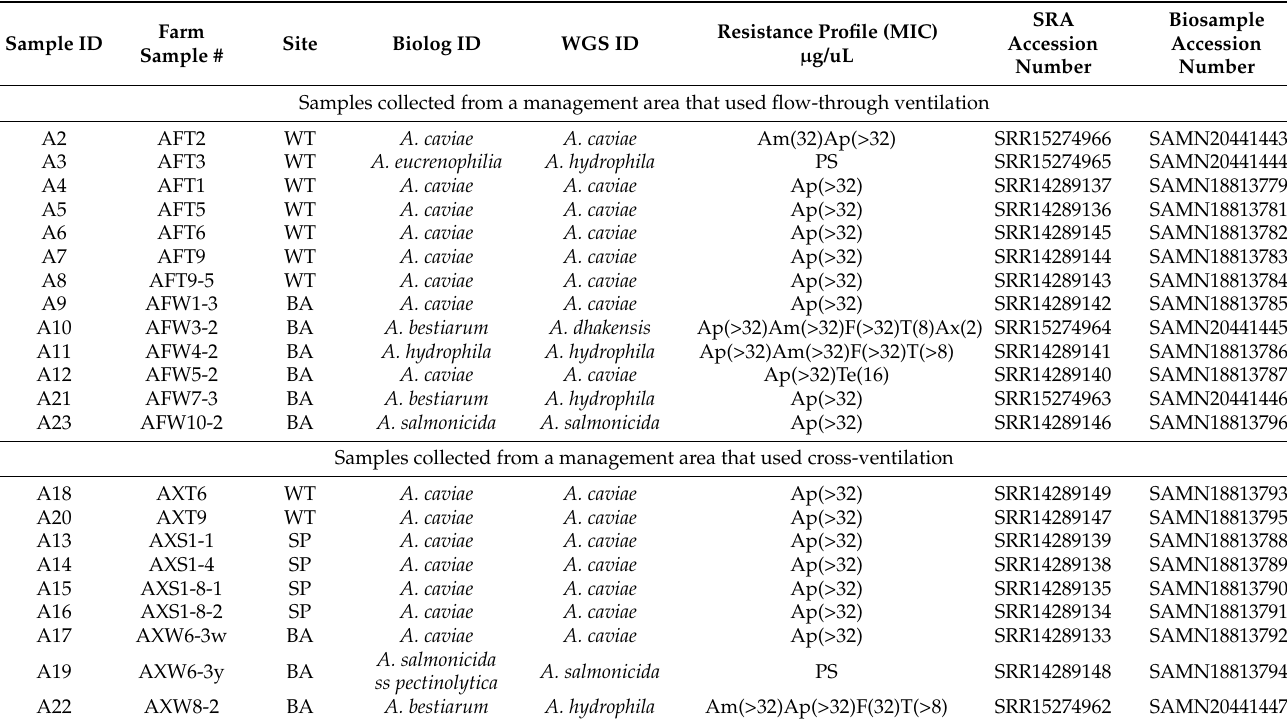
Table 1. Aeromonas spp. collected from a central Texas dairy